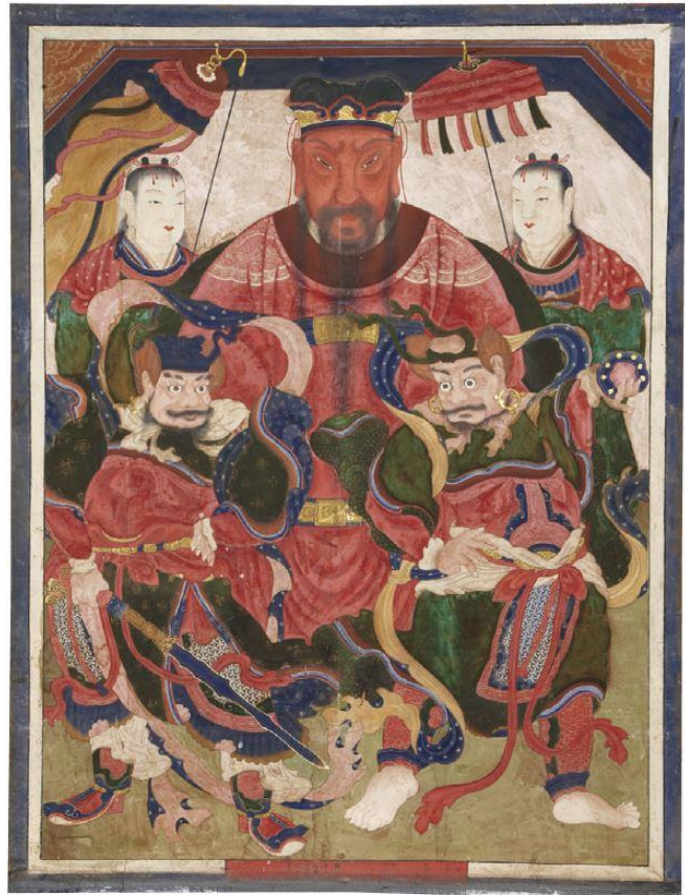
Figure 4. Taeh ŏ Chehun 大虛體勳 and Hakh ŏ 鶴虛 . Kwanje/Temple God (Toryangsin 道場神 ), 1885. Figure 4. Taehŏ Chehun 大虛體勳 and Hakhŏ 鶴虛 . Kwanje/Temple God (Toryangsin 道場神 ), 1885. Chos ŏ n dynasty (1392–1910). Mounted painting, colors on silk. 150.5 cm × 112.4 cm. Ultimate Bliss Chosŏn dynasty (1392–1910). Mounted painting, colors on silk. 150.5 cm × 112.4 cm. Hall, H ŭ ngch’ ŏ n Monastery, Seoul. Photograph by Chang Chi-h ŭ i, 2019. Image licensed under Cre- ative Commons, reproduced with permission from the Korean Cultural Heritage Administration,